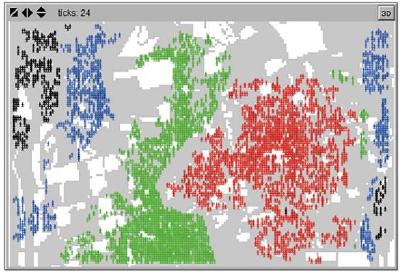
Figure 11-3: Segregation pattern resulting from satisfaction level of 80% in neighborhood radius 2